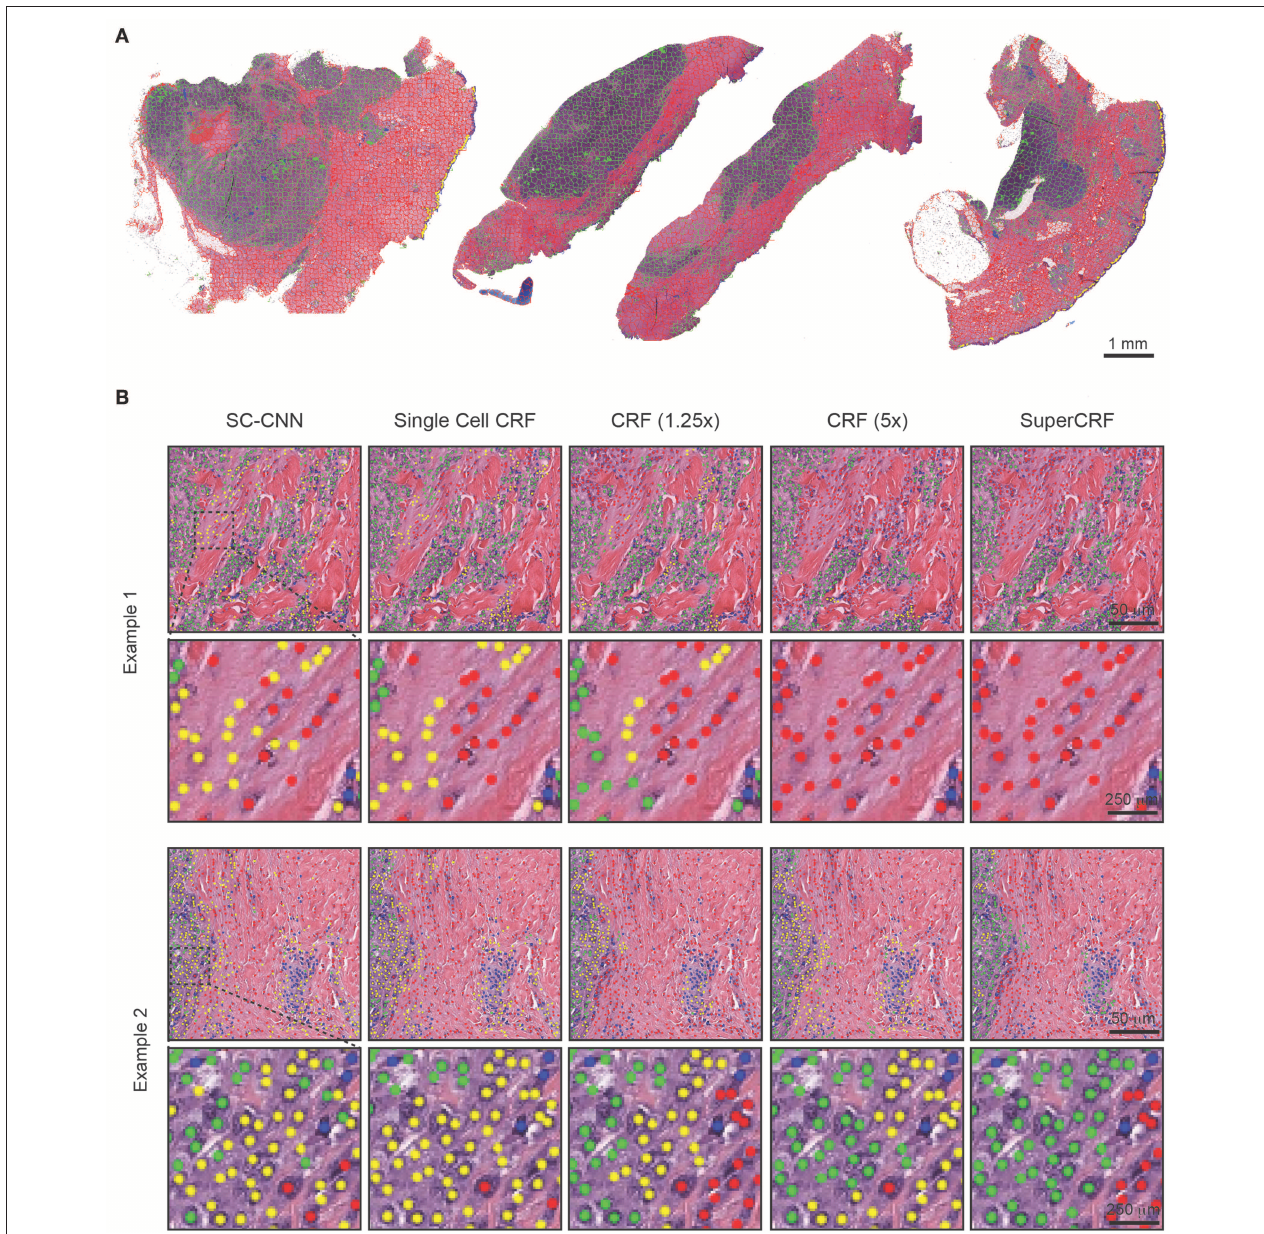
FIGURE 2 | Representative examples of both superpixel and single-cell classification with or without SuperCRF. (A) Superpixels-based regional classification on representative whole slide images (5 × magnification) of melanoma. Green: tumor area, Red: stroma area, Blue: normal epidermis, Yellow: lymphocyte cluster. (B) Representative images showing cell classification using a state-of-the-art spatially constrained-convolution neural network (SC-CNN) and four conditional random fields (CRF) models. Note the mislabeling of many cancer and stromal cells as epidermis cells when using the SC-CNN and the gradual increase in classification accuracy with the best accuracy achieved with the SuperCRF. Green, cancer cells; Red, stromal cells; Blue, lymphocytes; Yellow, epidermis cells.